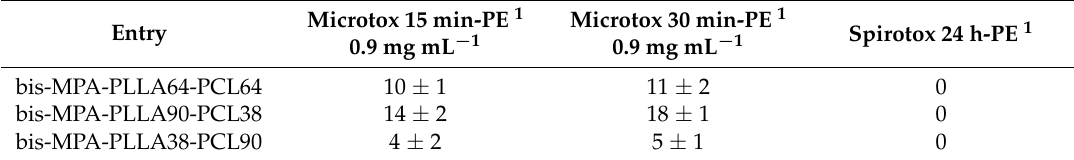
Table 2. The cytotoxicity results of the synthesized branched copolymeric matrices.